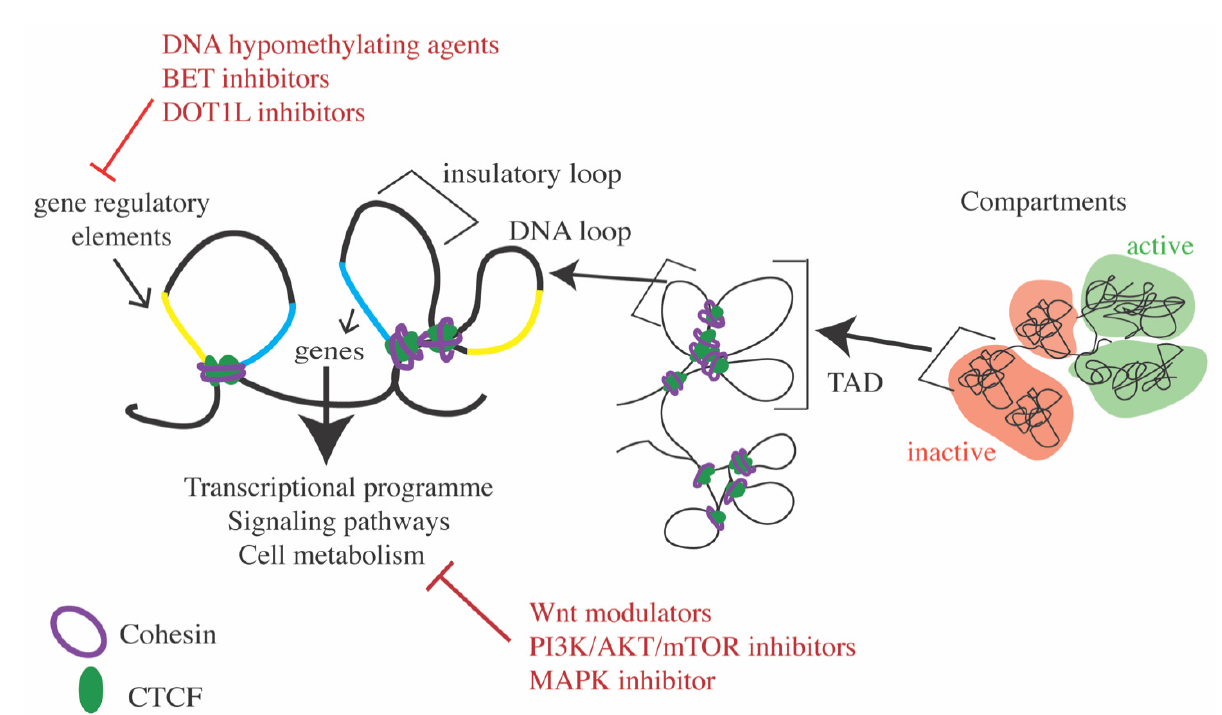
Figure 2. Cohesin’s role in the hierarchical 3-dimensional organization of the genome. Cohesin association with DNA during interphase is required for formation of DNA loops and organization into TADs. DNA loops allow genes to either connect to their regulatory elements (enhancers) or insulate them from ectopic connections. TADs based on transcription and epigenetic modifications segregate into active and inactive compartments. Cohesin mutation can result in aberrant DNA loops, which leads to transcriptional dysregulation. Pharmacological agents that modulate the epigenetic modifications at gene regulatory elements or directly target gene transcription and associated signaling can be used to interfere with the aberrant gene transcription observed in cohesin mutant cells.